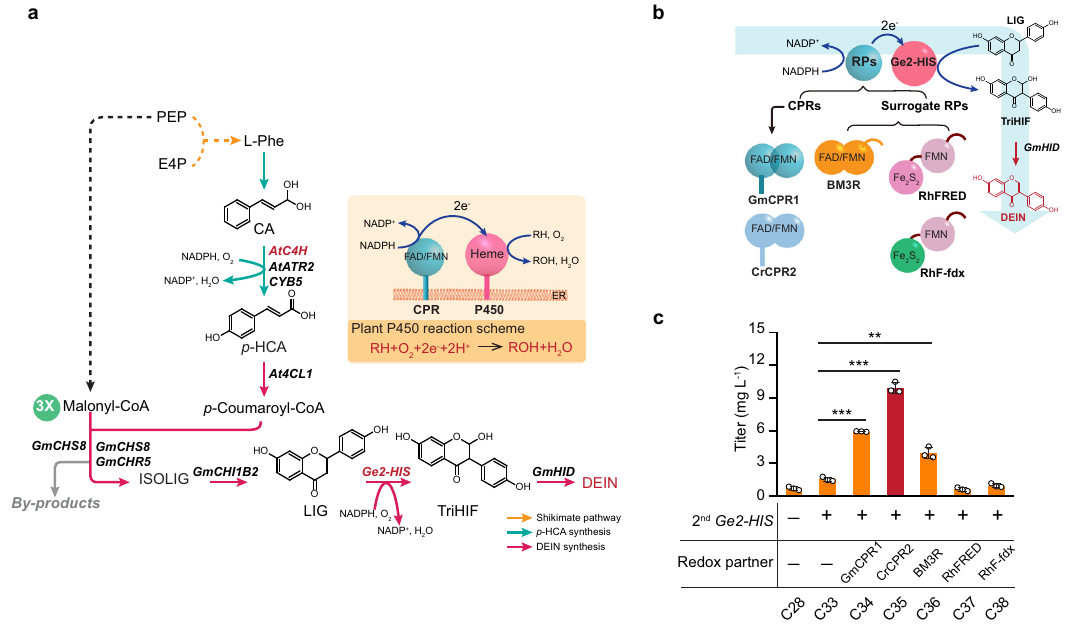
Fig. 3 Tailoring the redox partner of Ge2-HIS for ef fi cient DEIN production. a Schematic illustration of the biosynthetic pathways leading to the production of DEIN and related byproducts. P450 enzymes are indicated in magenta. In addition, a general catalytic mechanism of the membrane-bound plant P450 is shown in the inset. See Fig. 1 and its legend regarding abbreviations of metabolites and gene details. b Different redox partners (RPs) including CPR and surrogate redox partners from self-suf fi cient P450s were tested to enhance the catalytic activity of P450 Ge2-HIS. GmCPR1 , cytochrome P450 reductase from G. max ; BM3R, the eukaryotic-like reductase domain of P450BM3 from Bacillus megaterium ; RhFRED, the FMN/Fe2S2-containing reductase domain of P450RhF from Rhodococcus sp. strain NCIMB 9784; RhF-fdx, a hybrid reductase by substituting Fe2S2 domain of RhFRED with ferredoxin (Fdx) from spinach. See Fig. 1 and its legend regarding abbreviations of metabolites and other gene details. c Effect of different RPs on the production of DEIN. Cells were grown in a de fi ned minimal medium with 30 g L − 1 glucose as the sole carbon source, and cultures were sampled after 72 h of growth for metabolite detection. Statistical analysis was performed by using Student ’ s t test (two-tailed; two-sample unequal variance; * p < 0.05, ** p < 0.01, *** p < 0.001). All data represent the mean of n = 3 biologically independent samples and error bars show standard deviation. The source data underlying panel ( c ) are provided in a Source Data fi